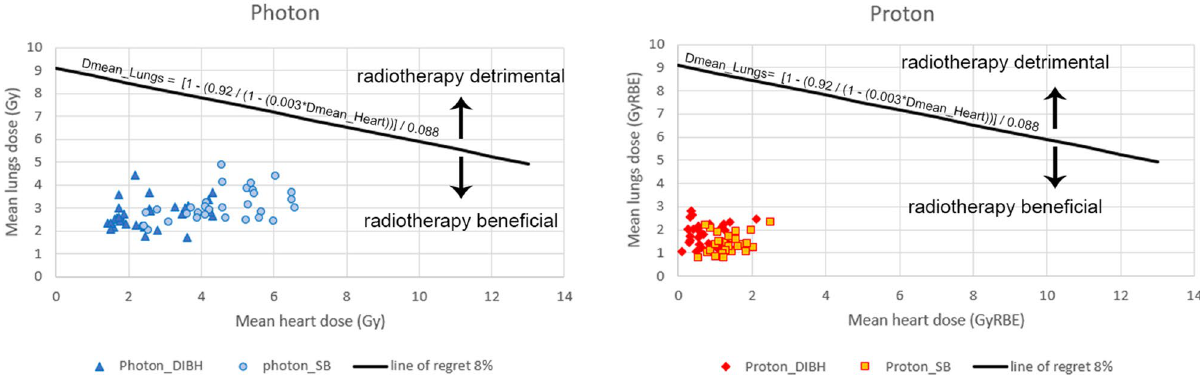
Figure 4. Risk–benefit classification of high-risk patients for cardiac events and lung cancer. Risk calculations based on cardiac and lung cancer mortality neglect risk-contributions from other radiation-induced cancers, such as esophageal, thyroid or contralateral breast cancer. Hence, radiation-related mortality risk is underestimated. Taylor’s data 7 are based on a variety of prescription doses, the most common being 25 × 2.0 Gy. The prescription dose in this study was 15 × 2.67 Gy. A weakness of these risk calculations is that neither total dose nor fractionation could be taken into